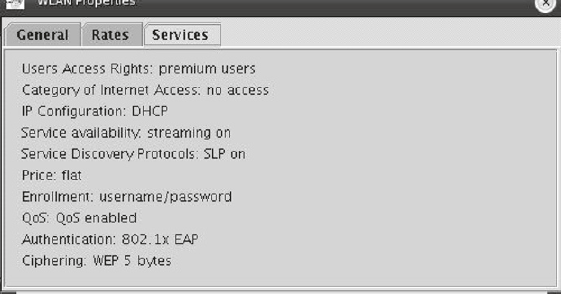
Figure 3: TWS: service characteristics of the